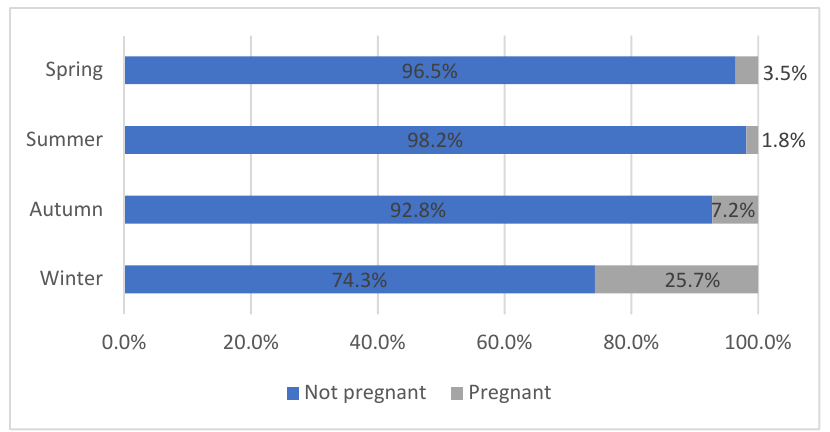
Figure 1. Pregnancy prevalence of female sheep and lambs at slaughter depending on the season.